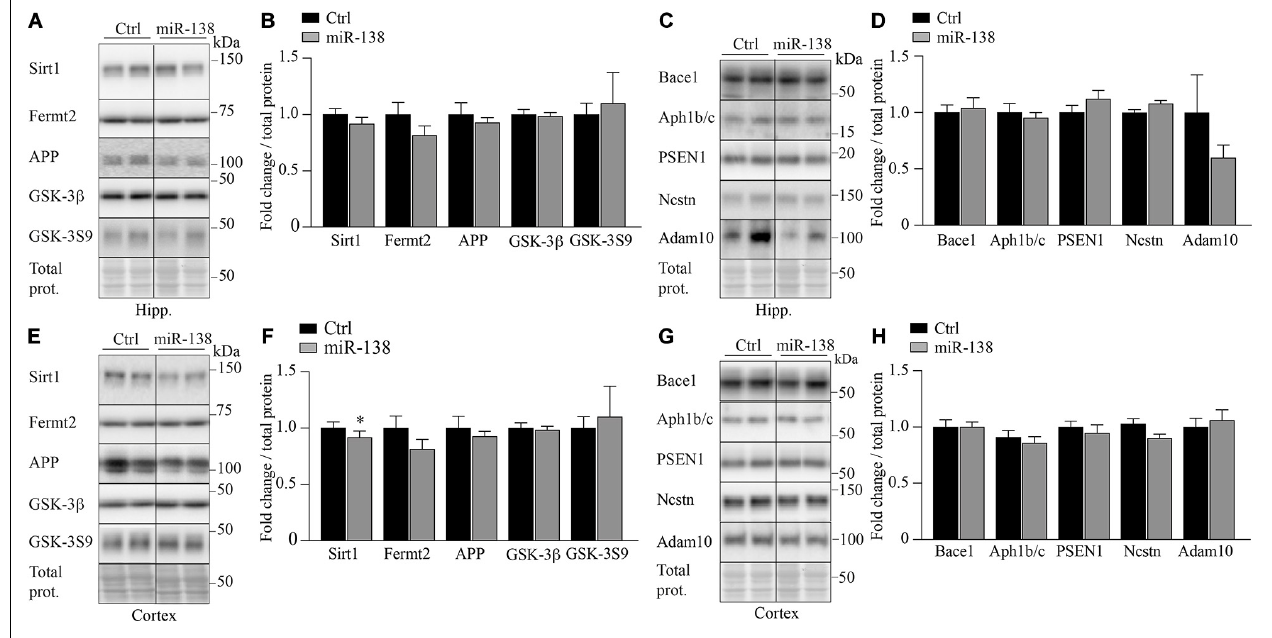
FIGURE 4 | Decrease of Sirt1 in miR-138 mice. (A) Representative Western blot of endogenous (B) Sirt1, Fertm2, APP, GSK-3 β , and GSK-3S9 quantification in hippocampus (Hipp.) of miR-138 mice compared to Ctrl mice, at 4 months of age. (C) Representative Western blot of endogenous (D) Bace1 Aph1b/c, PSEN1, Nicastrin (Ncstn), and Adam10 quantification in hippocampus (Hipp.) of miR-138 mice compared to Ctrl mice. (E) Representative Western blot of endogenous (F) Sirt1, Fertm2, APP GSK-3 β , and GSK-3S9 quantification in frontal cortex (Cortex) of miR-138 mice compared to Ctrl mice, at 4 months of age. (G) Representative Western blot of endogenous (H) Bace1 Aph1b/c, PSEN1, Nicastrin (Ncstn), and Adam10 quantification in frontal cortex (Cortex) of miR-138 mice compared to Ctrl mice. Bands were normalized to total proteins. All analyses were performed on 30 mice in total ( n = 13 males and n = 17 females). Data are presented as ± SEM: * P < 0.05, ** P < 0.01, *** P < 0.001 (unpaired student t